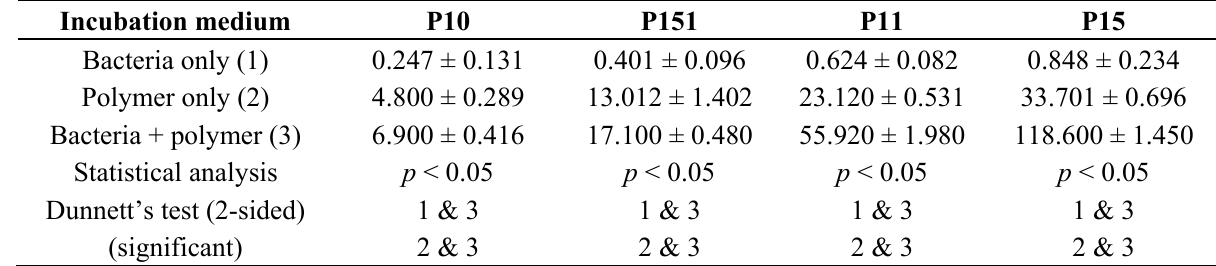
Table 4. The thiol concentrations (×10 − 6 mol L − 1 ) for incubation at 180 h in the presence of bacteria (3). Control experiments were carried out where bacteria alone, without polymer, were incubated in phosphate buffer (1) and polymer was incubated with phosphate